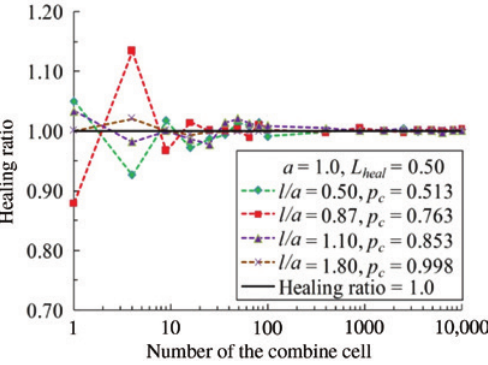
Figure 10: A parallelogram representative region E of x and y (